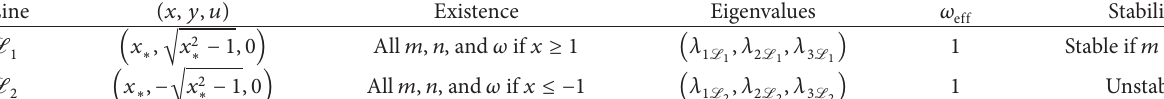
is defined in (25). 1